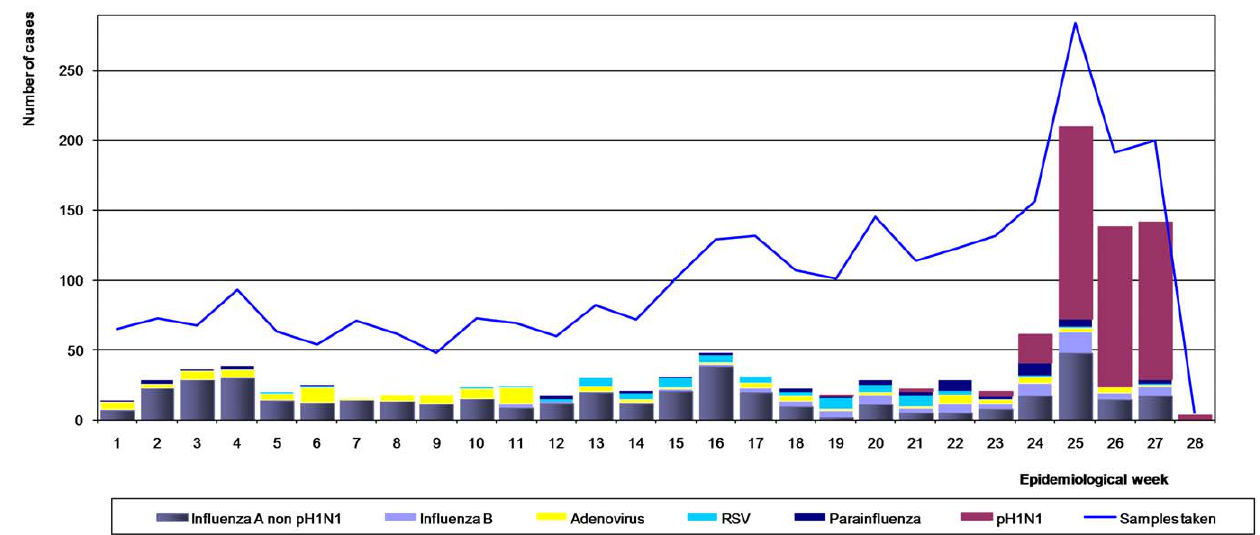
Figure 1. The temporal viral distribution by epidemiological week (EW) in Peru, January 4 to July 13, 2009.